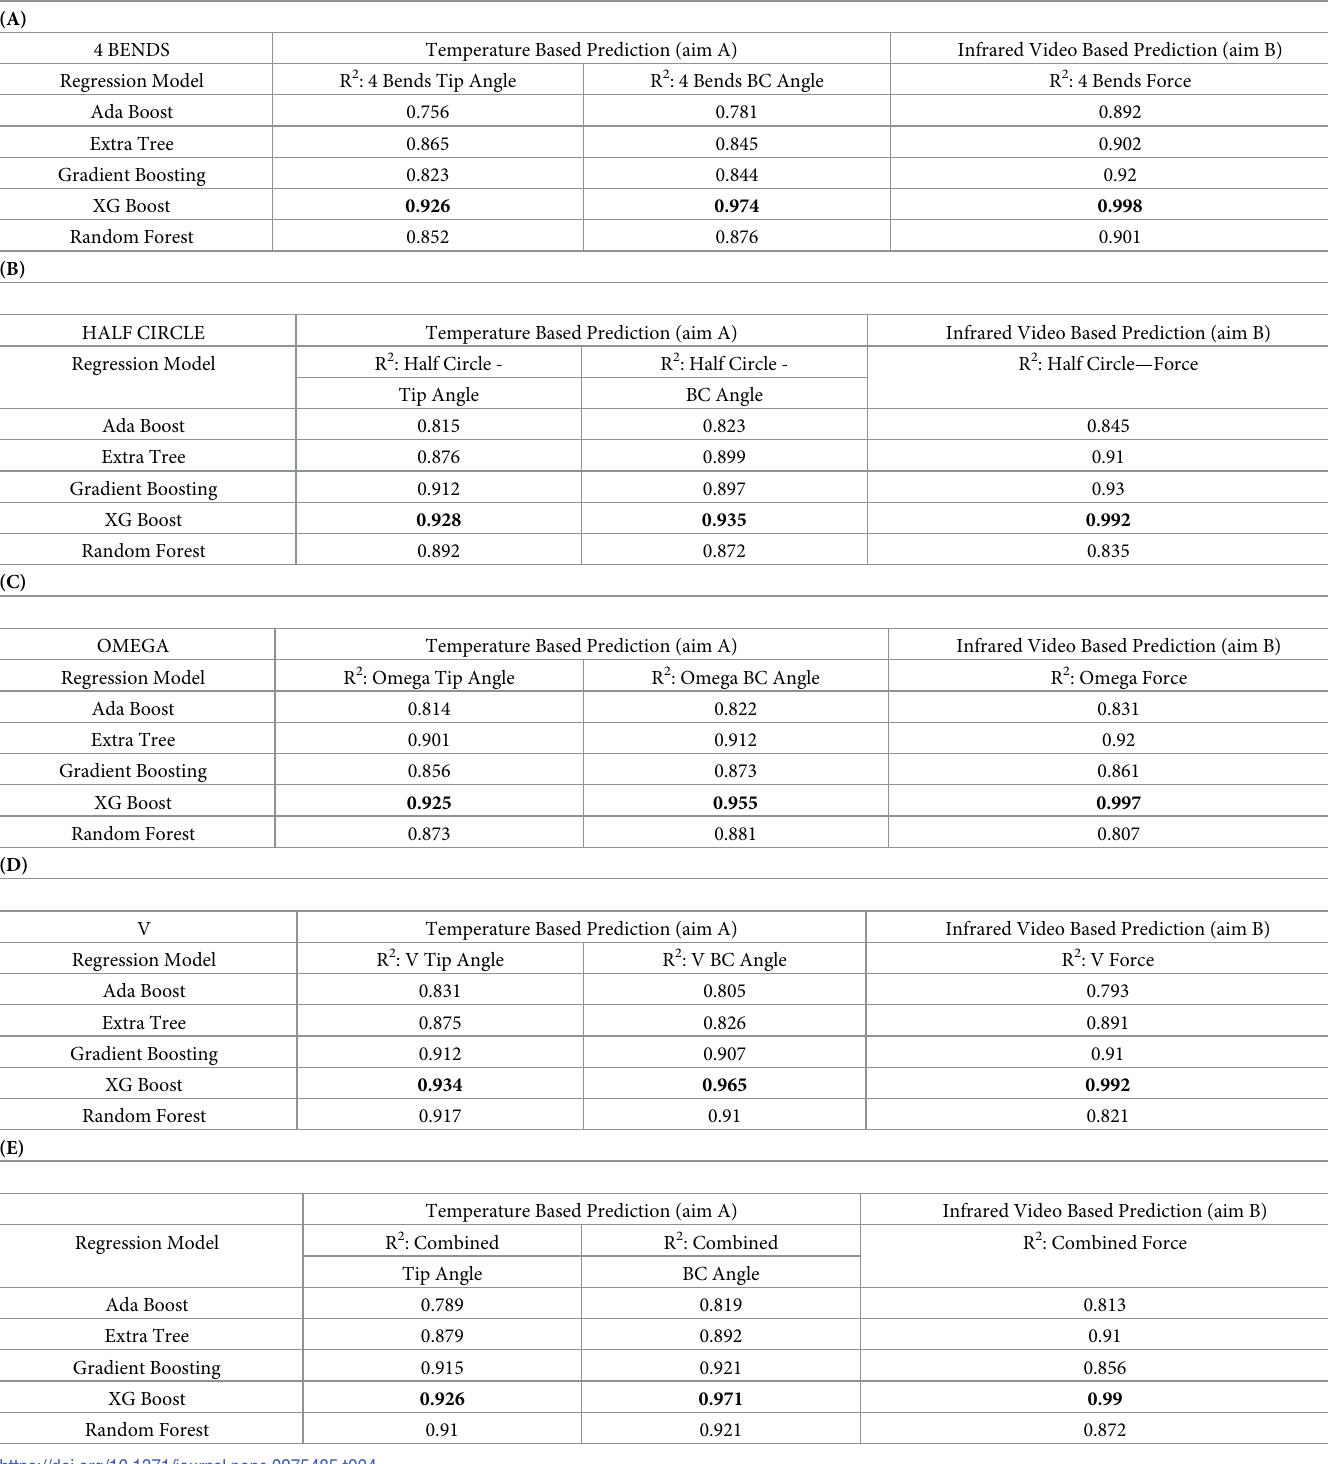
Table 4. (A) The mean R 2 score results from the comparative predictive regression analysis while experimenting with “4 BENDS” SMA shapes. (B) The mean R 2 score results from the comparative predictive regression analysis while experimenting with “HALF CIRCLE” SMA shapes. (C) The mean R 2 score results from the comparative predictive regression analysis while experimenting with “OMEGA” SMA shapes. (D) The mean R 2 score results from the comparative predictive regression analysis while experimenting with “V” SMA shapes. (E) The mean R 2 score results from the comparative predictive regression analysis while experimenting with all four SMA shapes combined in a single data